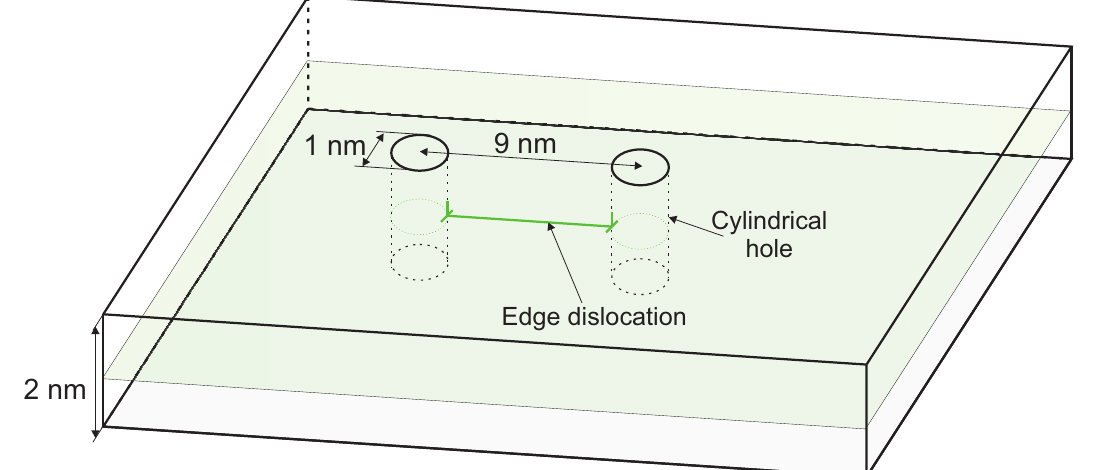
Figure 3. Model of the Frank–Read source in iron showing a dislocation segment of length 9 nm terminated by cylindrical holes of radius 0.5